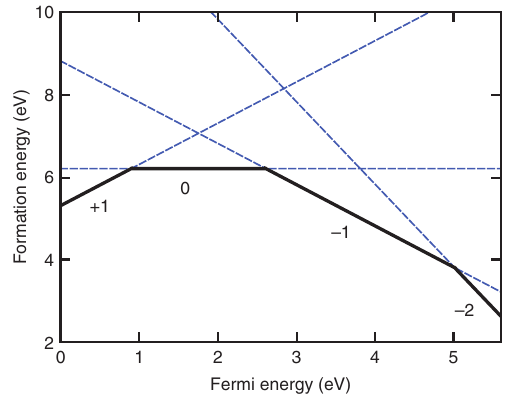
Figure 3: Formation energy of NV center in diamond [124]. The chemical potential of nitrogen was set to the energy of nitrogen atom in the nitrogen molecule at T = 0 K. The crossing lines correspond to the adiabatic ionization energies. The Fermi level is aligned to the top of the valence band. We note that these data differ, in particular, for the donor level from Ref. [131], which was obtained in a small 64-atom